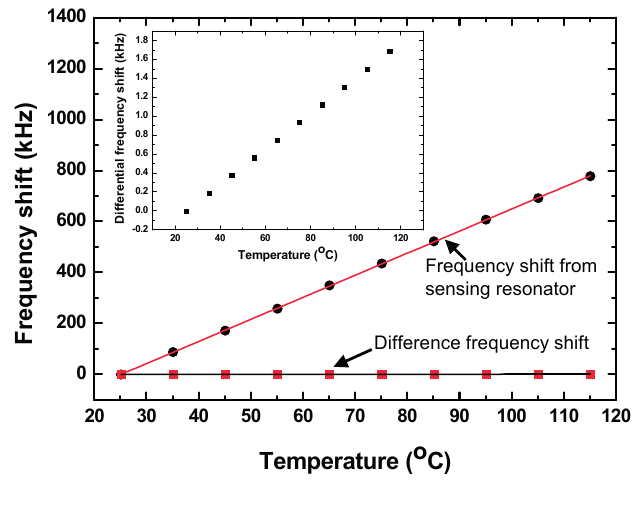
Figure 8. Measured frequency-dependence from the sensing resonator and differential structure, inset: an expansion of the difference